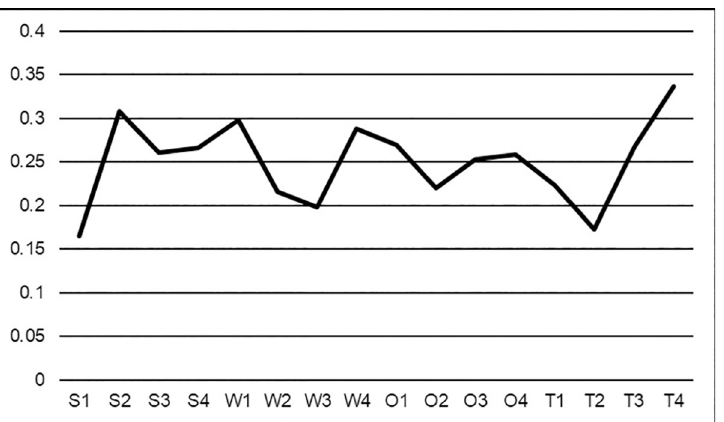
Fig 7. The overall average priority scores of each SWOT factor from the first survey. S1: enhanced environmental services, S2: income opportunities, S3: participation in existing networks, S4: connection to land, W1: limited knowledge of forest management, W2: lack of women-centric outreach programs, W3: limited women forest professionals, W4: absence of initial contact, O1: peer-to-peer educational opportunities, O2: community development, O3: access to new markets, O4: enhanced job opportunities for women, T1: investment risks, T2: lack of representations, T3: absenteeism, T4: limited interest from future